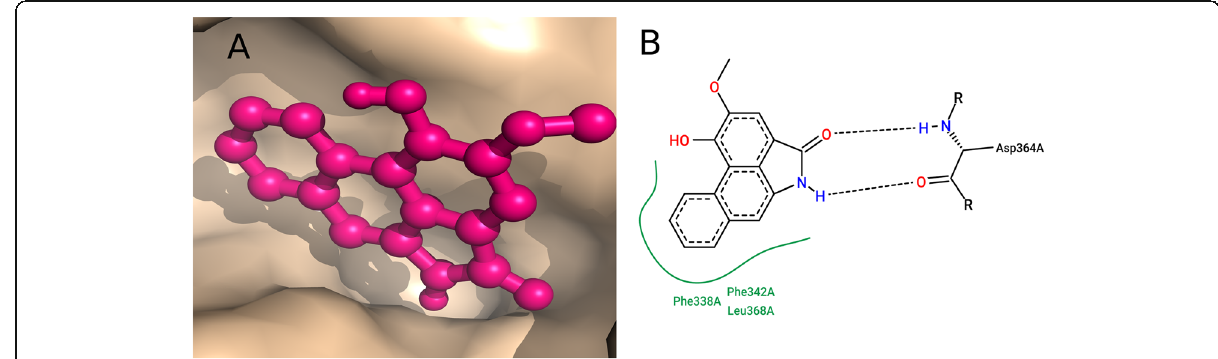
Fig. 3 Piperolactam A docked with S-protein. a Surface image of Piperolactam A docked with the Region 1 of 6X6P S-protein. b 2D Interaction map of the Piperolactam A with the S-protein. Interaction profiles indicate two H-bond with